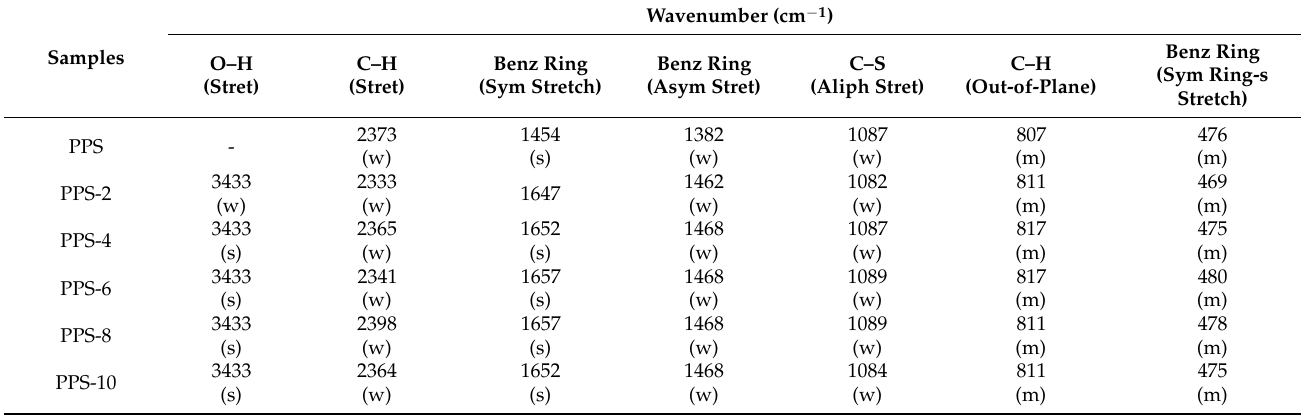
Table 5. FTIR data of PPS@BC nanocomposites.